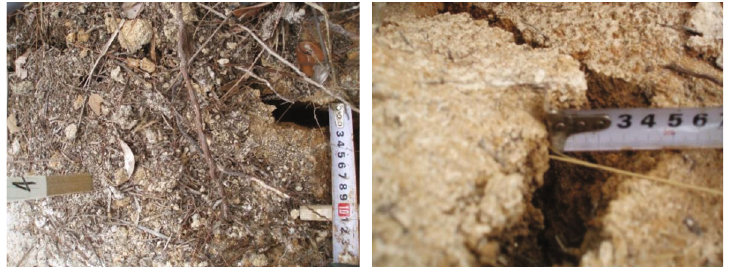
Figure 9: Fresh crack appeared in the monitoring